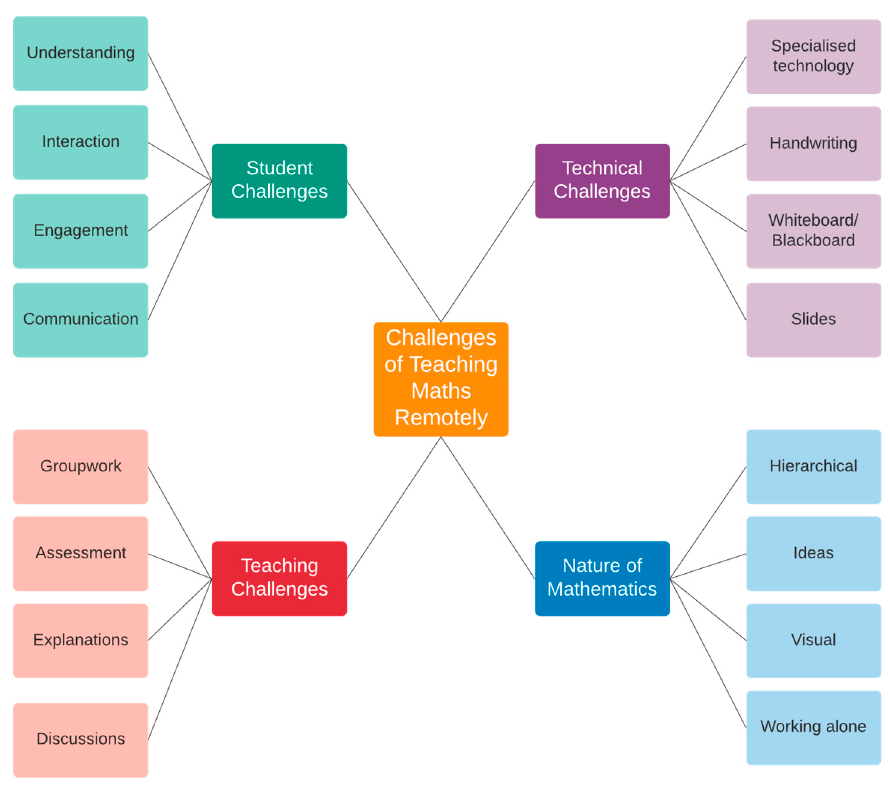
Figure 5. Themes and sub-themes in response to the question “Do you think that teaching mathemat- ics online differs in any way from teaching other disciplines online? Please comment”.